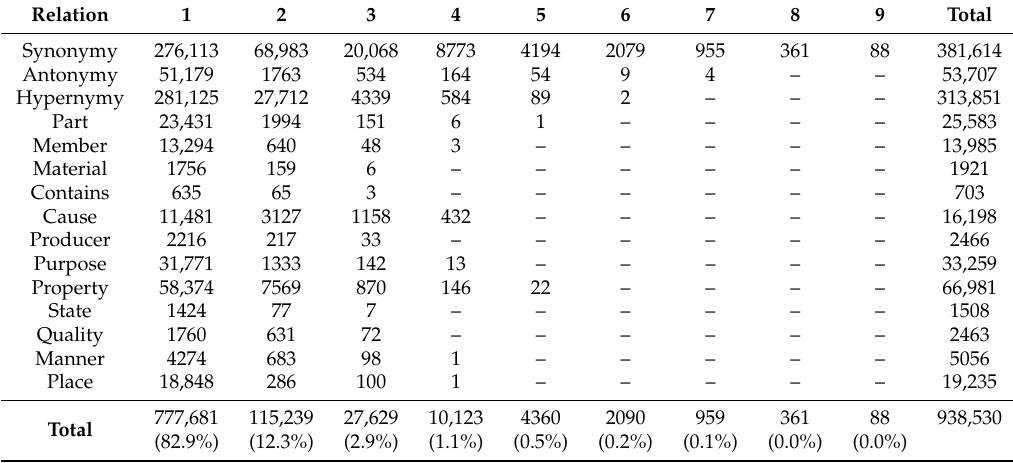
Table 4. Occurrences of the same triples in different resources, per type.